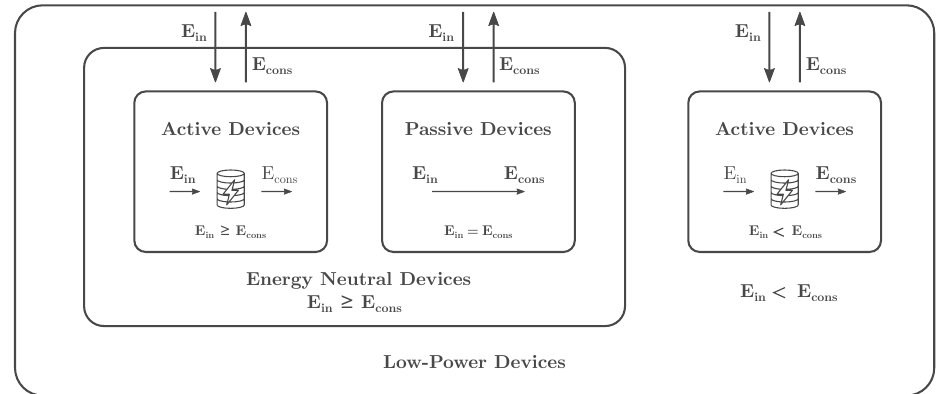
Figure 1. Classification of low-energy devices illustrating the definition of energy neutrality for both active and passive